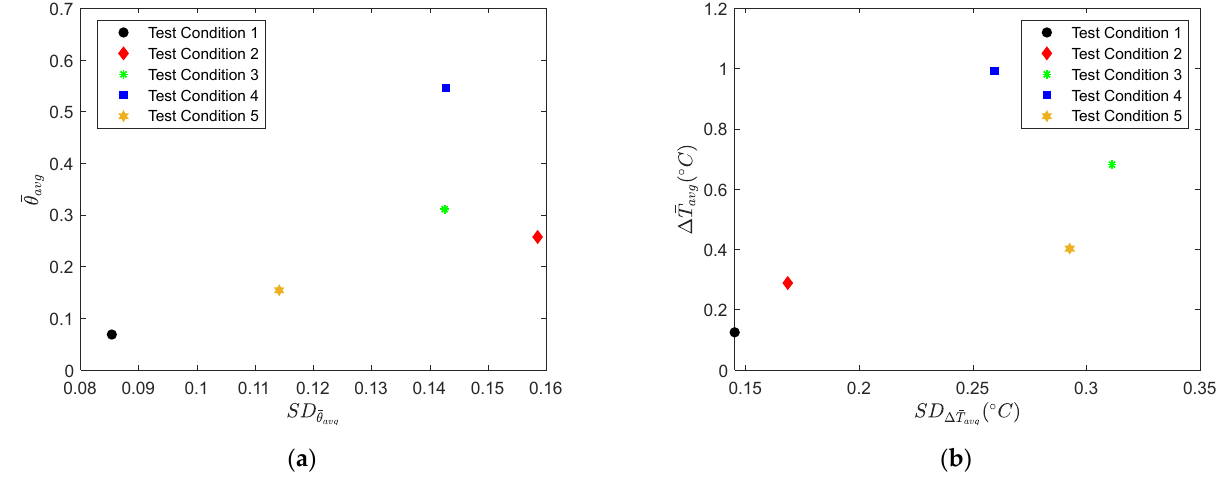
Figure 10. Comparison of average ( a ) dimensionless temperature difference at the corresponding standard deviation of the average dimensionless temperature differences, and ( b ) temperature difference at the corresponding standard deviation of the average temperature differences for each test condition.